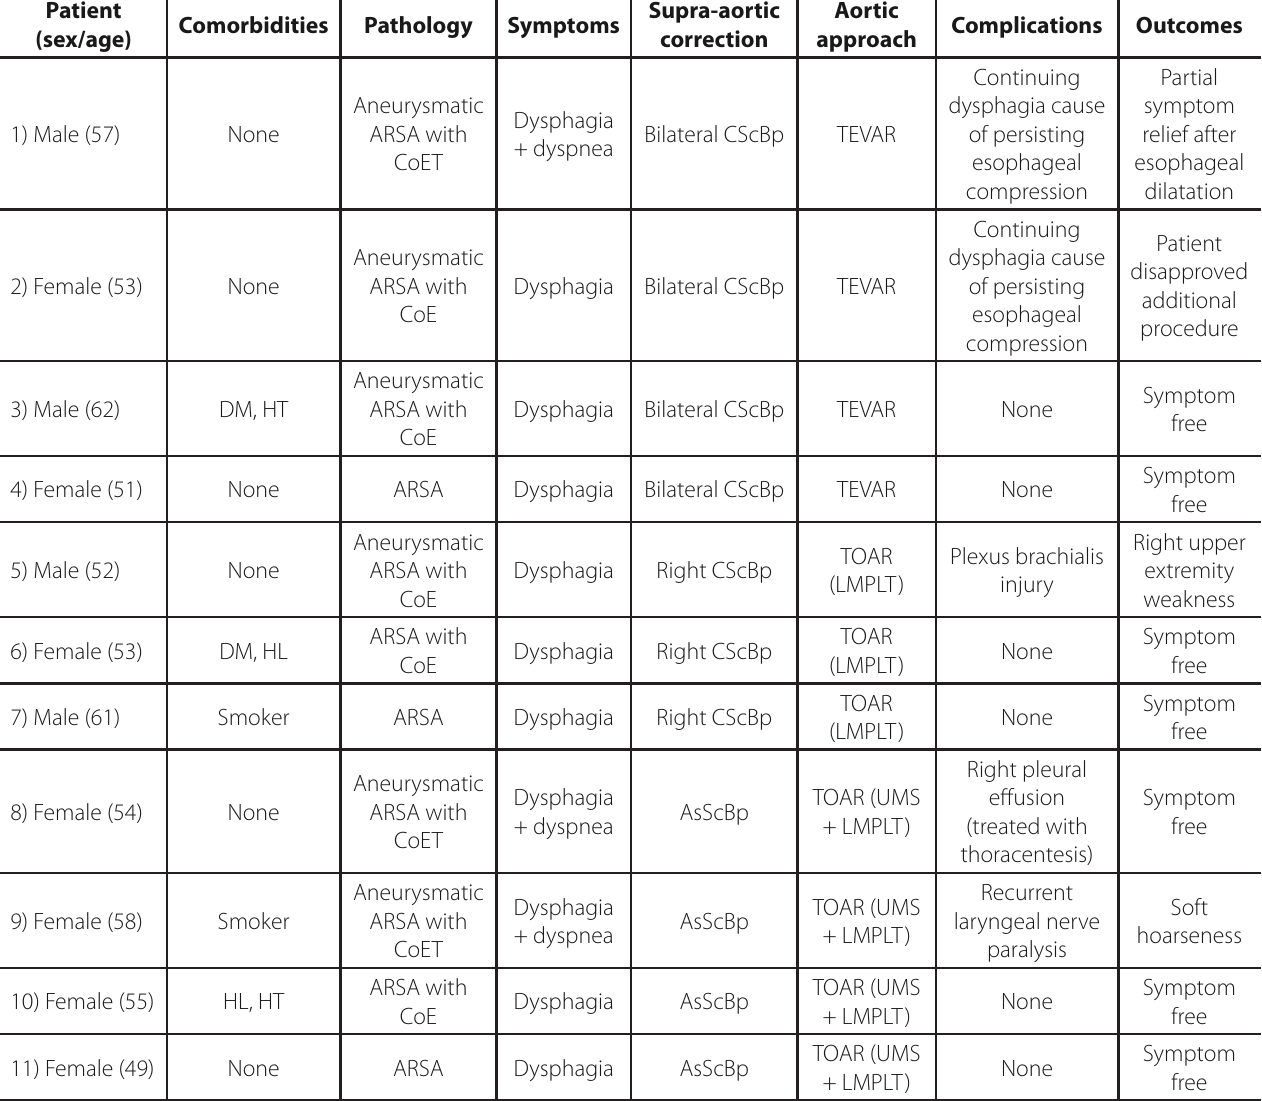
Table 1. Individual patient characteristics, presentation, and